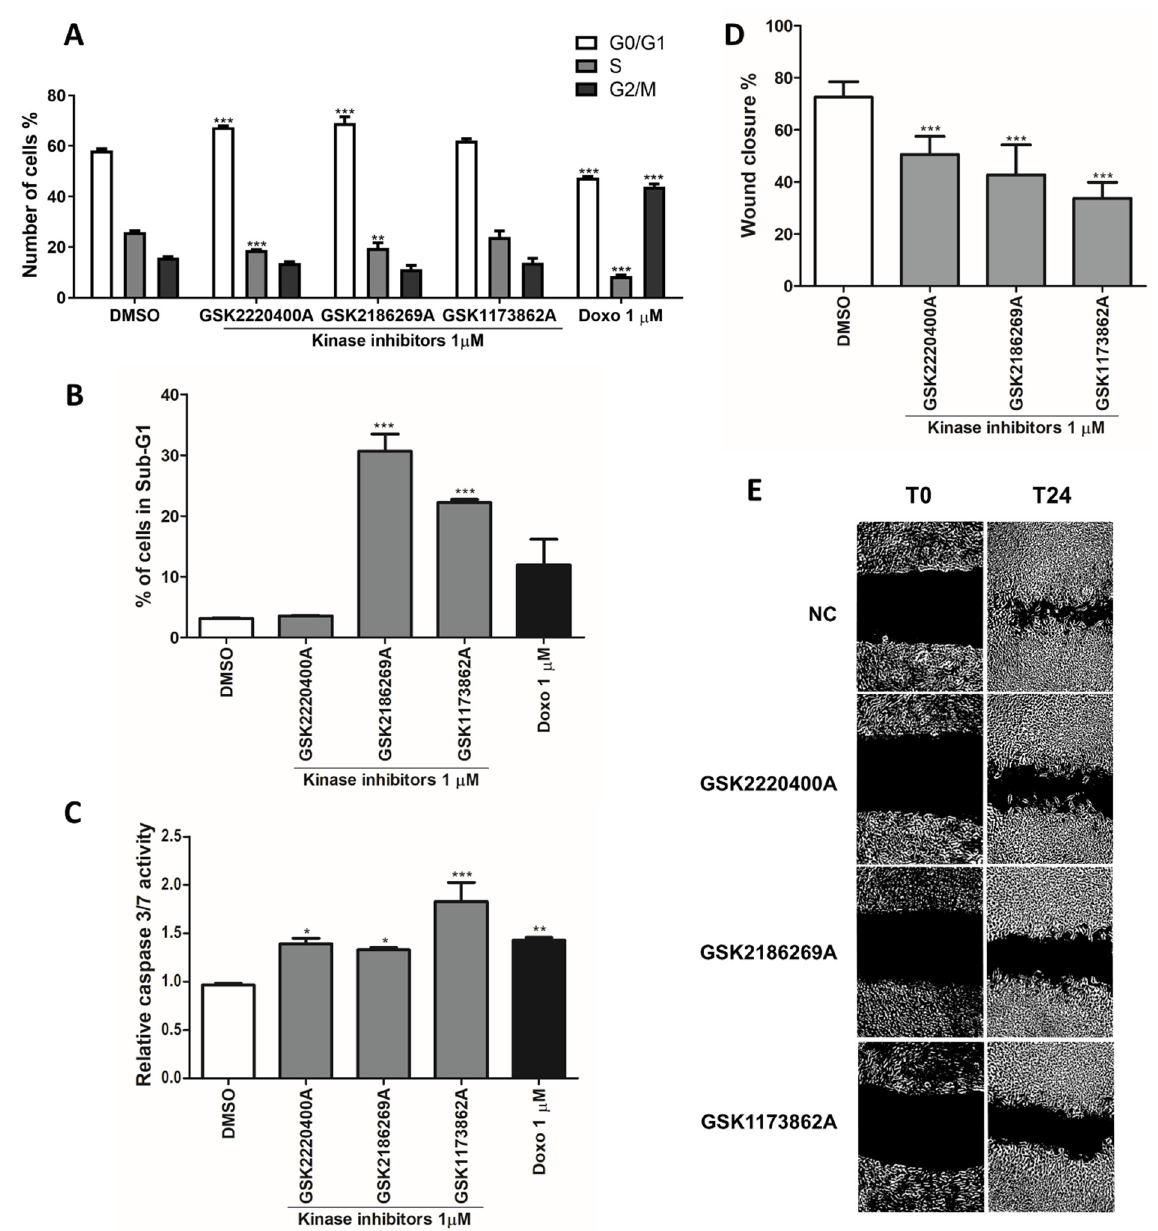
Figure 2. Anti-cancer effects of the three selected kinase inhibitors. ( A ) Cell cycle phase distribution of metastatic gastric cancer cells after 72 h of kinase inhibitors treatment. ( B ) Percentage of cells in sub-G1 phase after kinase inhibitors treatment. ( C ) Caspase 3 and 7 activities after 72 h of 1 µM kinase inhibitors exposure against metastatic gastric cancer cells. ( D , E ) Inhibitory effect on cell migration after 24 h of kinase inhibitors treatment. Mean ± standard deviation. Significant differences compared to untreated control: * p < 0.05, ** p < 0.01, *** p < 0.001.